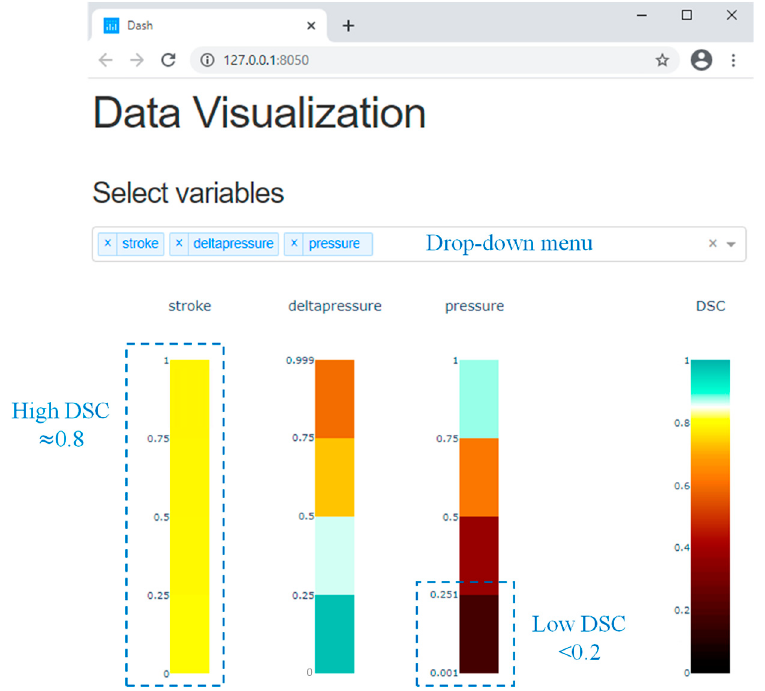
Figure 10. Annotated screenshot of the visualization of data set completeness in the training data set.